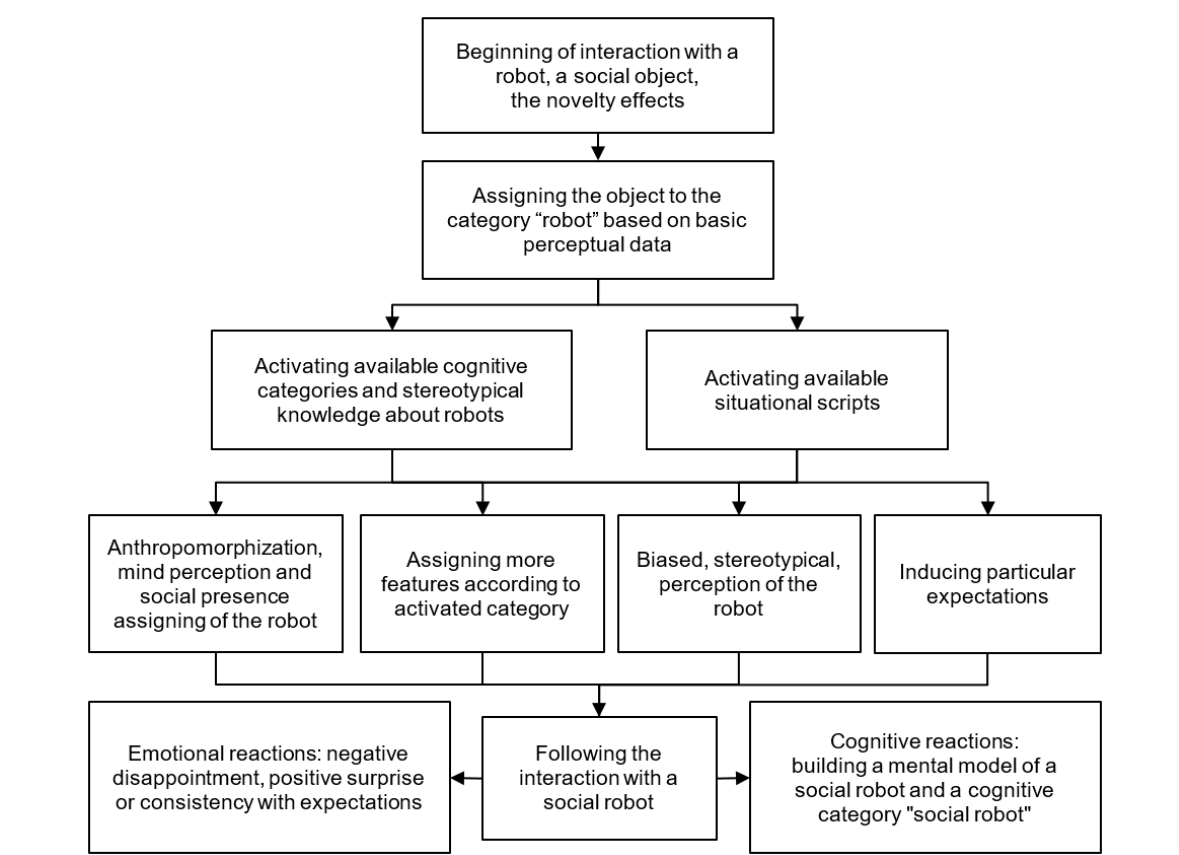
Figure 1: An integrated model of human-robot first